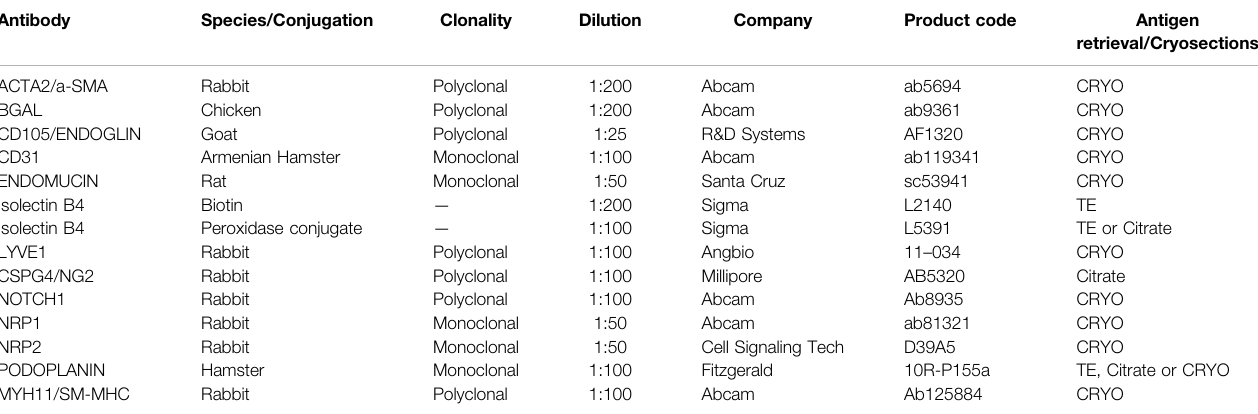
TABLE 1 | Antibodies and optimised conditions for